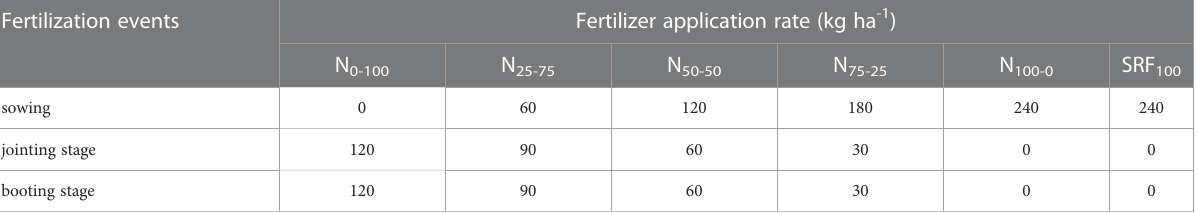
TABLE 2 Fertilizer application schedules of the experimental treatments. Fertilization events